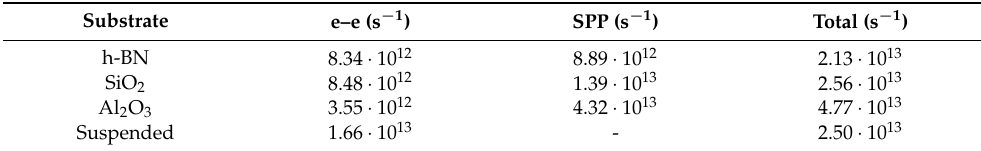
Table 3. Number of the most relevant scattering mechanisms per unit time, i.e., carrier–carrier interaction and SPP, suffered by the carriers on the different samples under study at E AC = 20 kV/cm. Furthermore, the total scattering events are